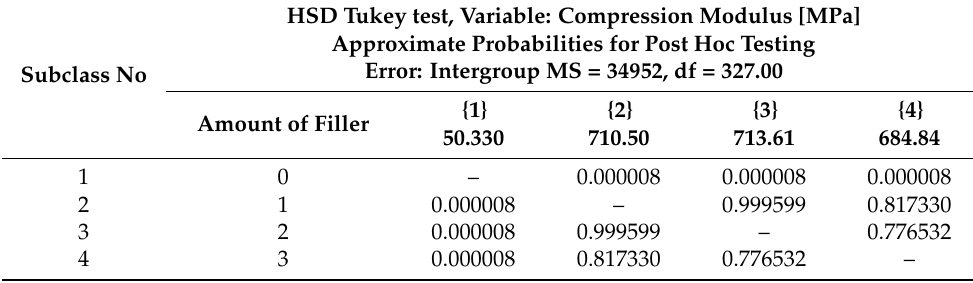
Table 8. Significant differences between the results sorted by amount of